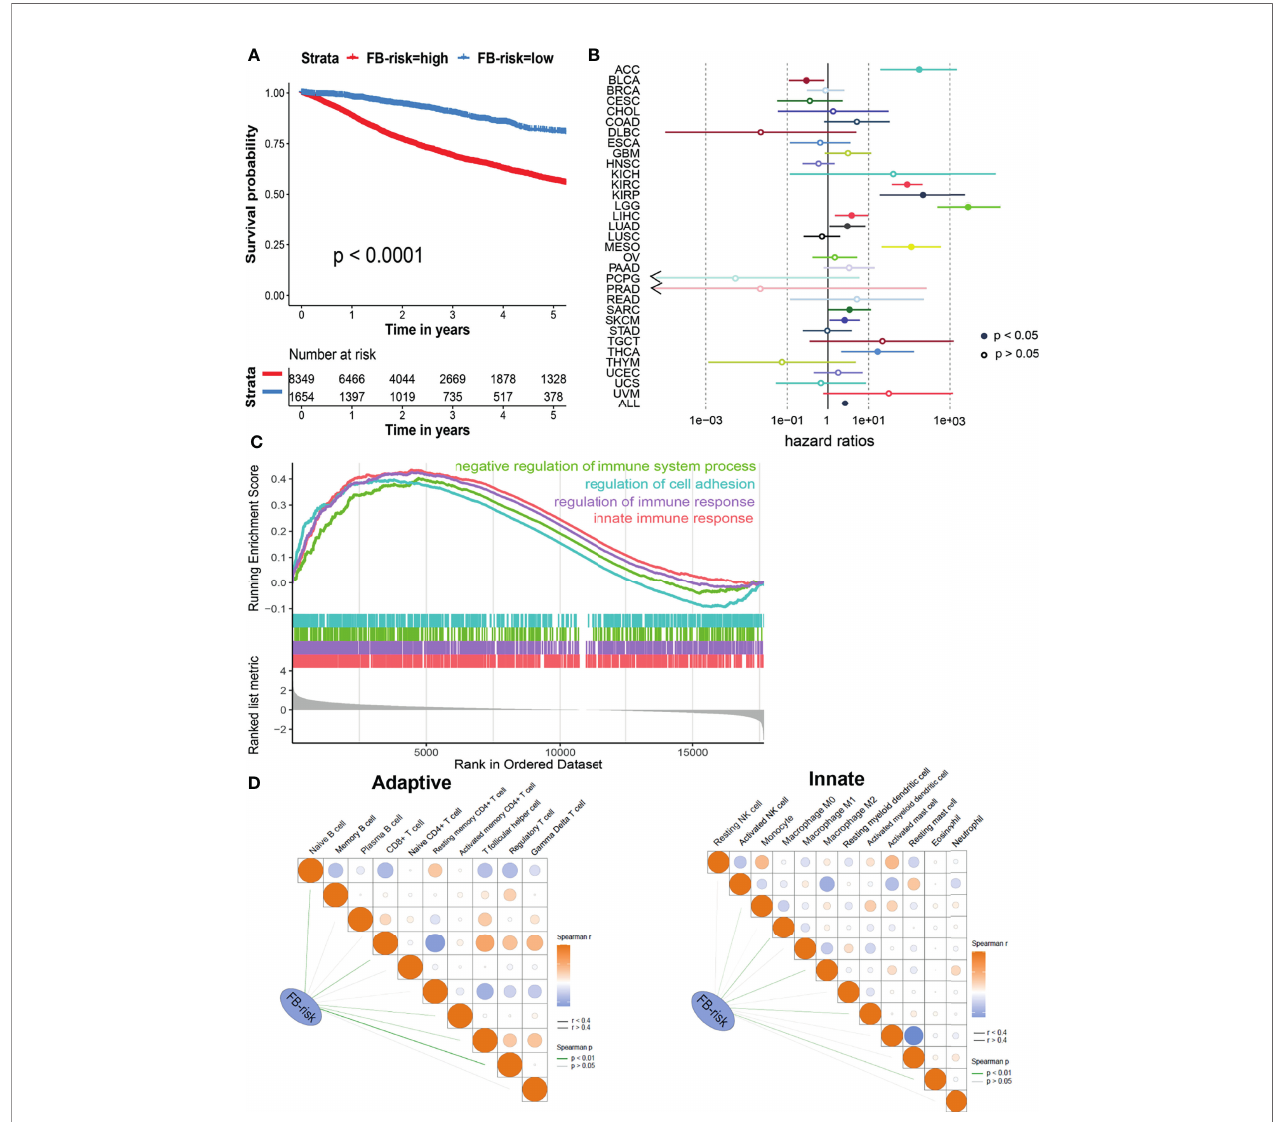
FIGURE 3 | Evaluation of the prognosis model in ccRCC. (A) Kaplan – Meier survival analysis of overall survival strati fi ed by FB-risk for pan-cancer patients from the TCGA dataset. (B) Cox regression analysis of deep learning-based FB-risk in different kinds of malignancies in the TCGA dataset. (C) Gene set enrichment analysis of patients with high FB-risk. (D) Correlation analyses of FB-risk and different adaptive immune cells (left)/innate immune cells (right) in the TCGA cohort. ccRCC, clear cell renal cell carcinoma; TCGA, The Cancer Genome Atlas; FB-risk, f-box family-related